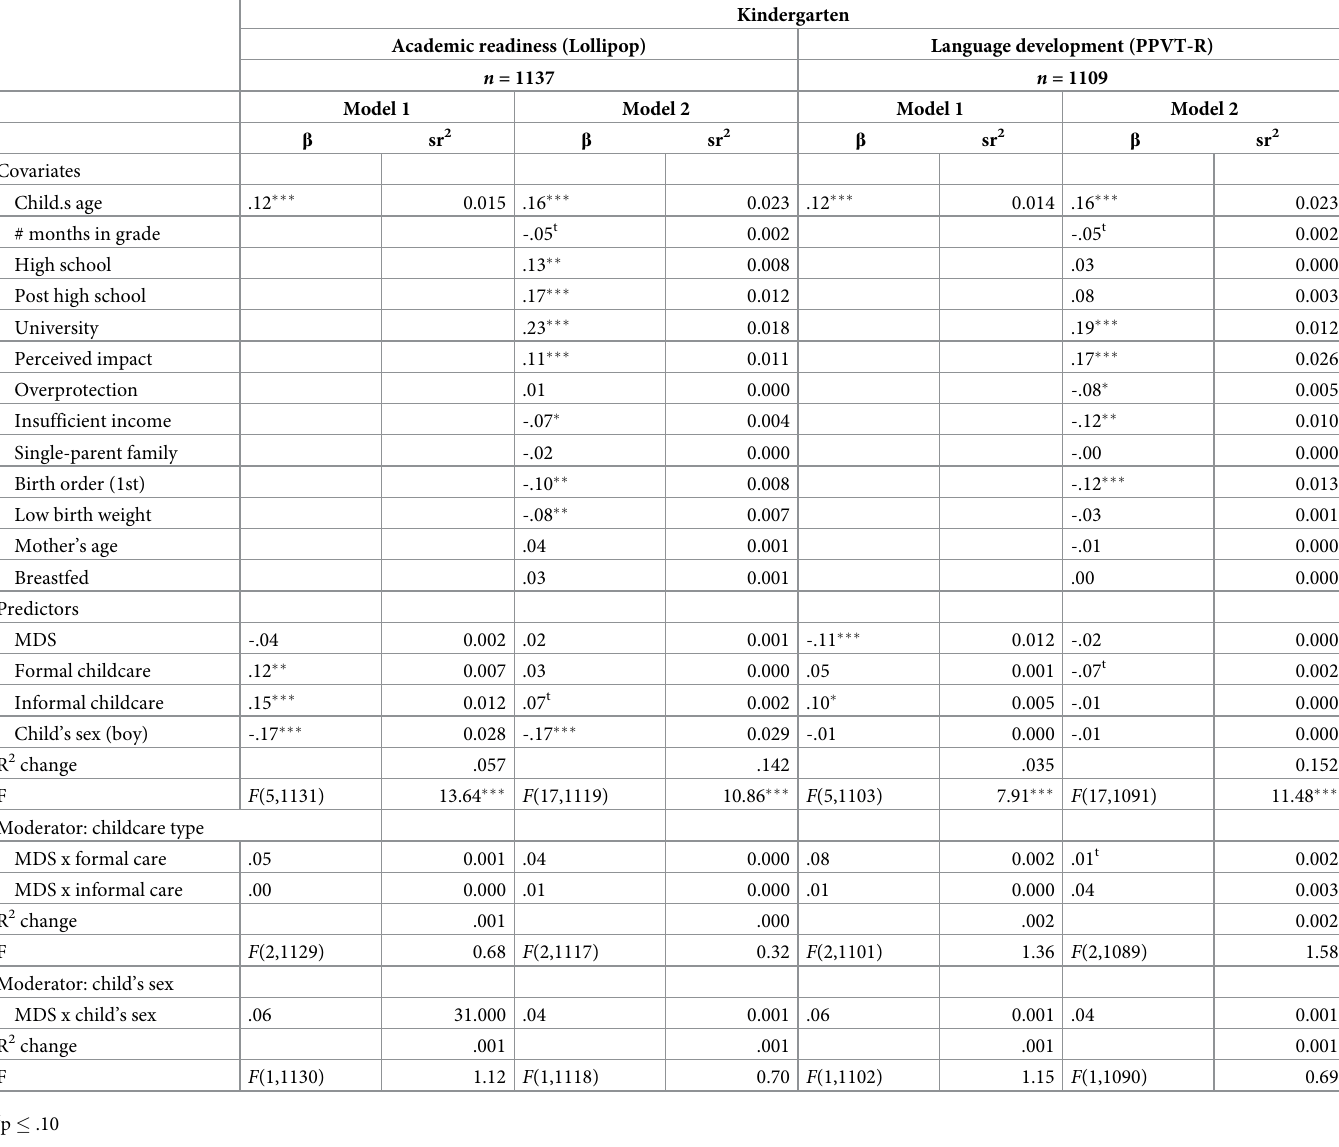
Table 2. Moderation analyses of MDS x Childcare type and MDS x child’s sex for kindergarten